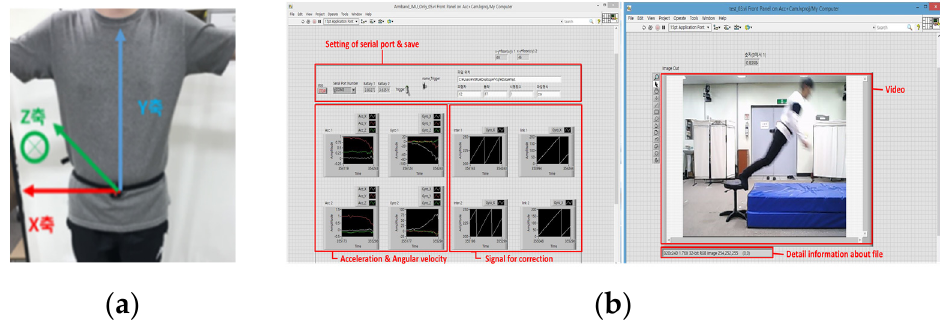
Figure 1. Instruments used in this study: ( a ) IMU and ( b ) GUI.